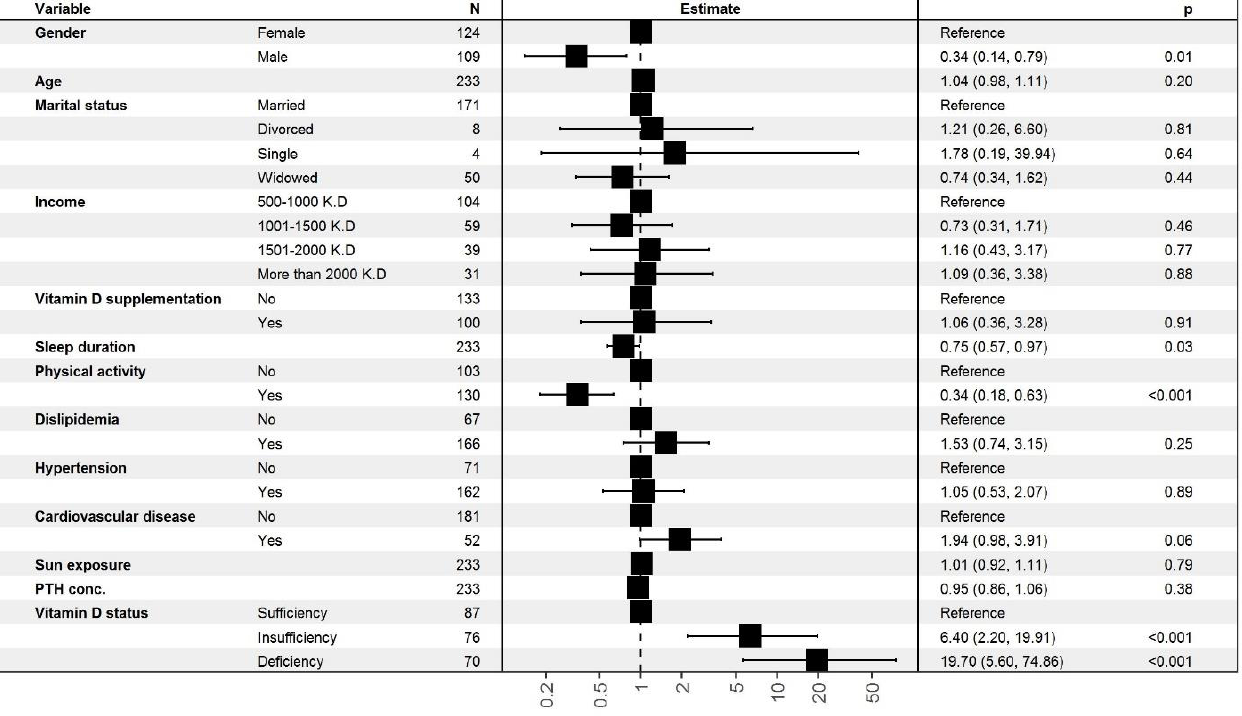
Figure 2. Multivariate association between GDS-15 and 25(OH)D.